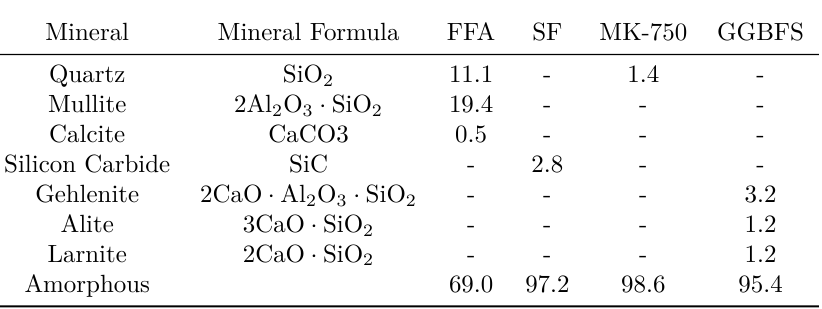
Table 3. Mineralogical Composition of precursors in wt.%.